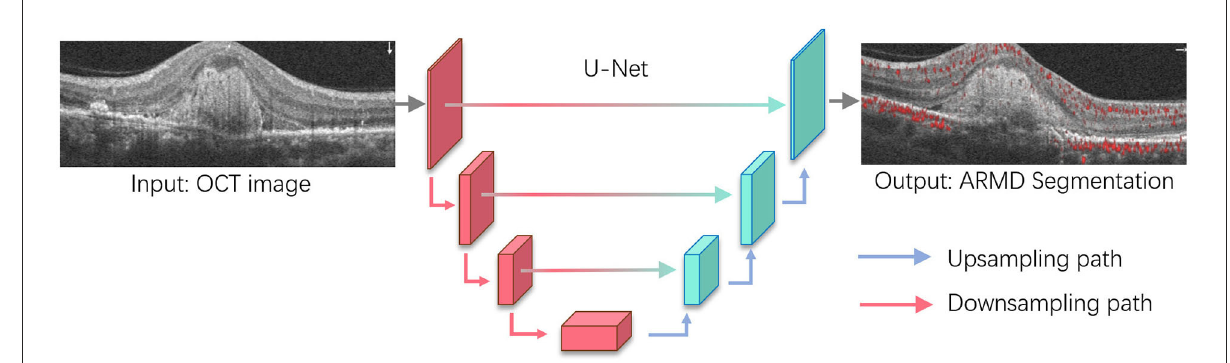
FIGURE4 Age-related macular degeneration (ARMD) lesions segmentation based on U-Net. U-Net is one of the most widely used segmentation architectures for biomedical images and stemmed from the fully convolutional network. The U-Net model consists of a downsampling path and upsampling path, where downsampling path has convolutional and max-pooling layers to extract high-level abstract information while the upsampling path has convolutional and deconvolutional layers that upsample the feature maps to output the segmentation outcomes. For ARMD segmentation, U-Net will take OCT images as the input and progressively extract semantic features that allow to separate the lesions from the surrounding background and output the lesion segmentation